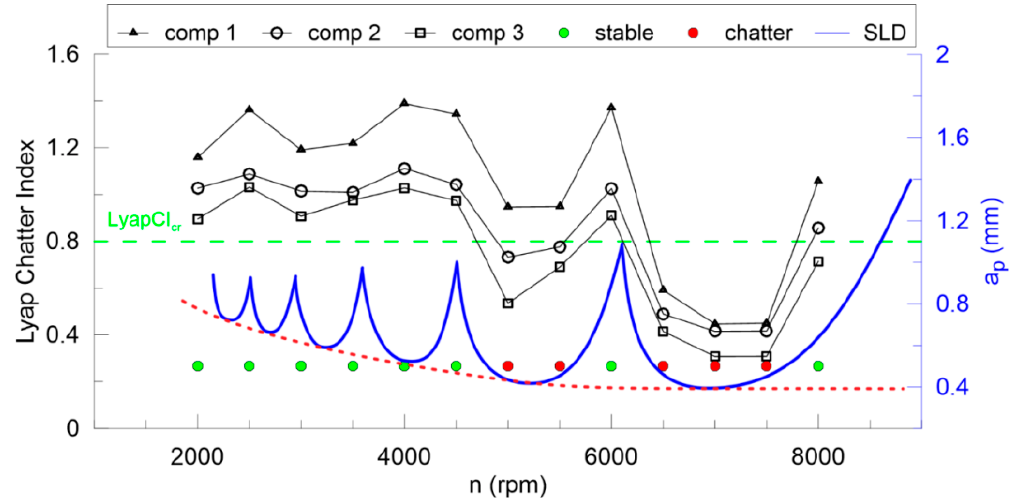
Figure 13. The largest Lyapunov chatter index (left axis) and the hypothetical stability lobe diagram (right axis) versus cutting velocity.